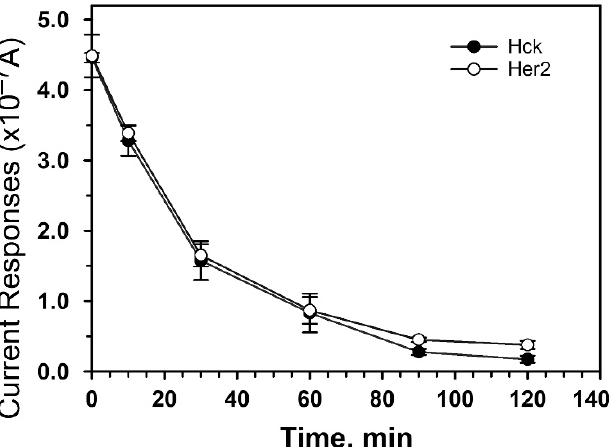
Figure 4. Time-dependent phosphorylation of peptide substrates by Hck and Her2. The phosphor- ylation of 100 μ M ELMO-Y511peptide (close circle) and 100 μ M FLT3 peptide (open circle) were performed by Hck (10 U/mL) and Her2 (10 U/mL), respectively, at 30 °C for 0, 10, 30, 60, 90 and 120 min. At each time point, 2- μ L of reaction mixture was withdrawn and subjected to electro- chemical measurement under the potential of − 0.2V. The data is mean ±S.D of three independent experiments.